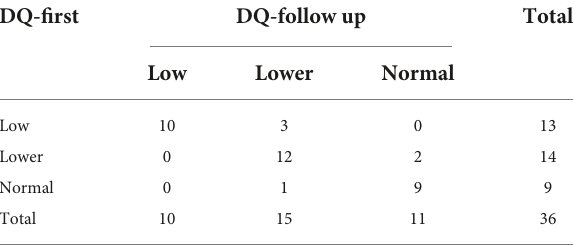
TABLE 4 Kappa test of DQ classification reproducibility before and after treatment in patients with cblC defects.